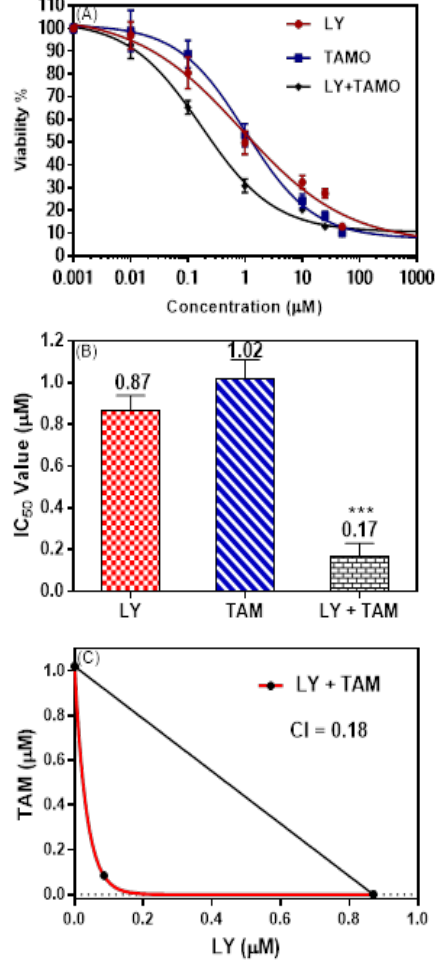
Figure 1. ( A ): Dose response curve, ( B ): IC 50 values, ( C ): isobolgram and combination index of MCF-7 cells treated with di ff erent concentrations of LY, TAM, and LY + TAM combination for 72 h. The IC 50 was calculated using GraphPad Prism V6 by fitting of sigmodal four parameter curve. The data expressed as mean ± SD ( n = 3, of three experiments). Statistical di ff erences, compared with the control cells, were assessed by a one-way ANOVA with the Tukey’s post-hoc multiple comparison test (GraphPad Prism). p < 0.001 (***) was taken as